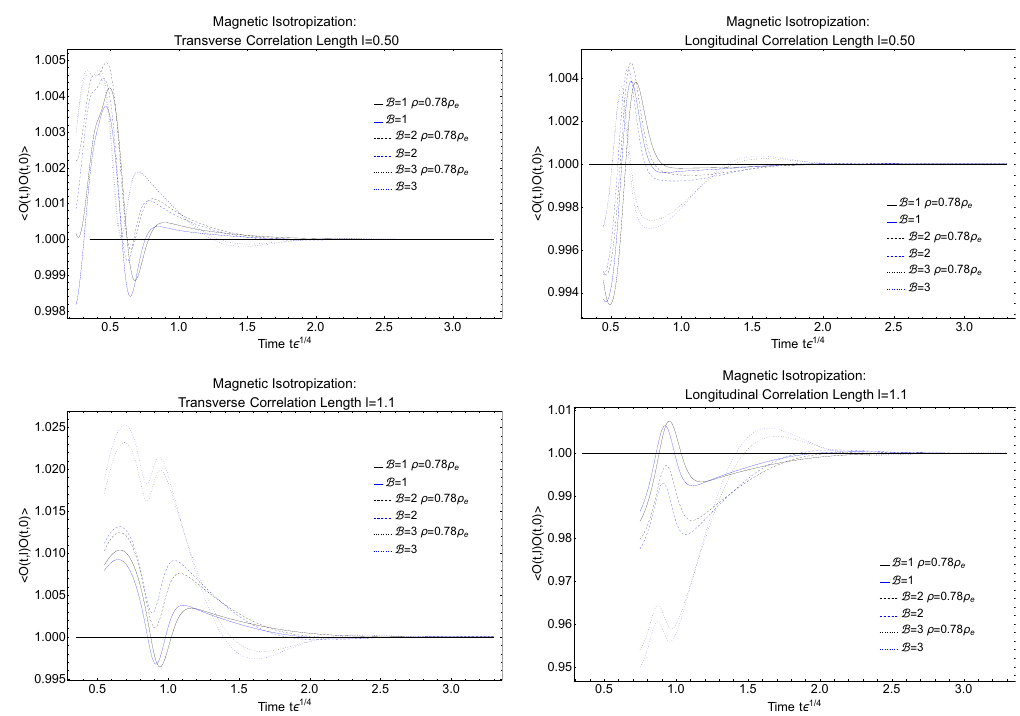
Figure 18 . Separation length dependence at various magnetic (cid:12)elds. 2-point correlation functions of an (uncharged) scalar operator in a charged magnetic thermalizing (cid:13)uid (dual to the evolution towards a charged magnetic black brane geometry), (cid:26) = 0 : 78 (cid:26) e , B = 1 ; 2 ; 3. Top Left: length separation of l = 0 : 50 in the transverse direction. Top Right: length separation of l = 0 : 50 in the longitudinal direction. Bottom Left: length separation of l = 1 : 1 in the transverse direction. Bottom Right: length separation of l = 1 : 1 in the longitudinal